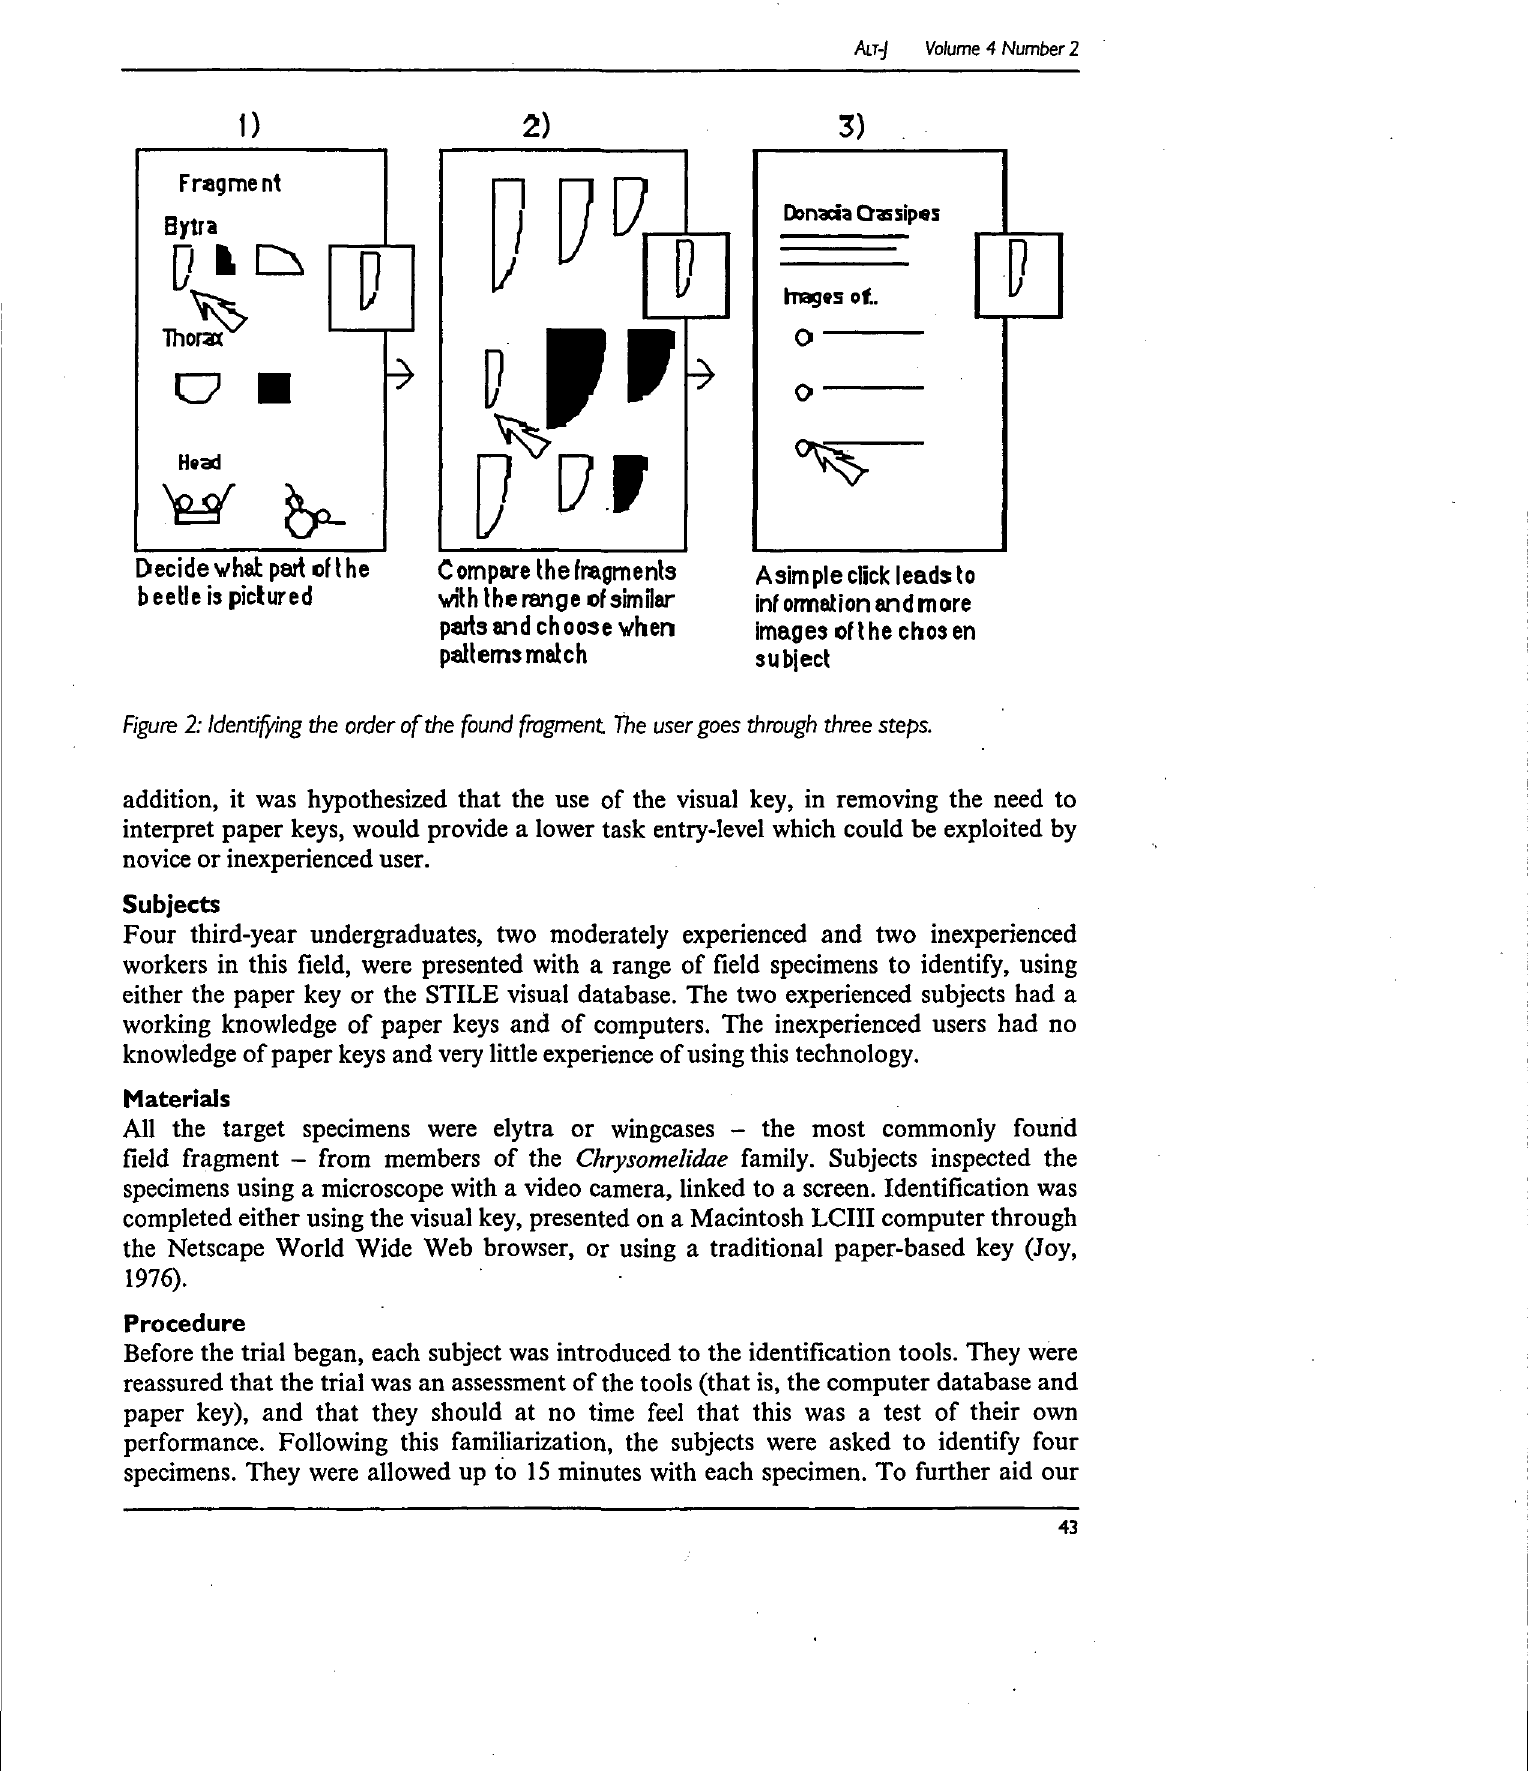
Figure 2: Identifying the order of the found fragment The user goes through three